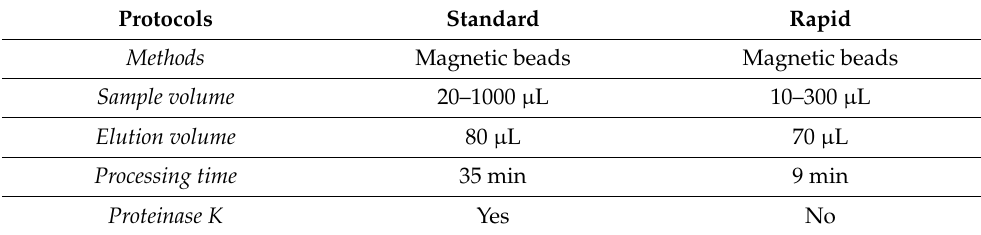
Table 2. Summary of the comparison between the rapid and standard